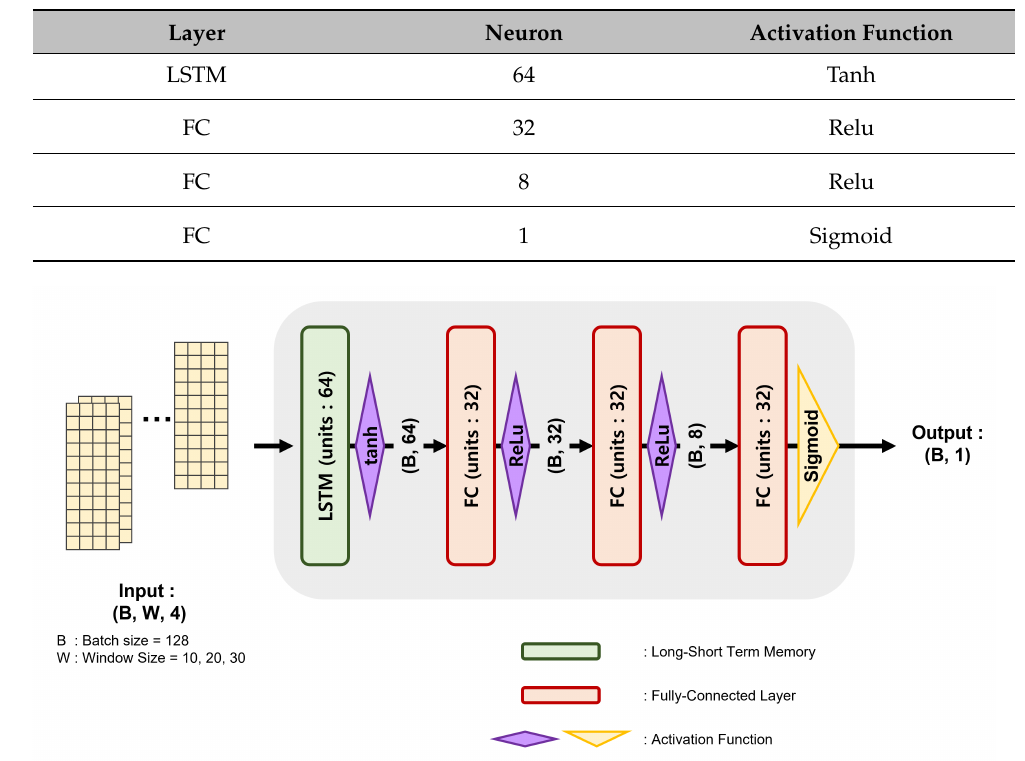
Table 4. HOD model structure.